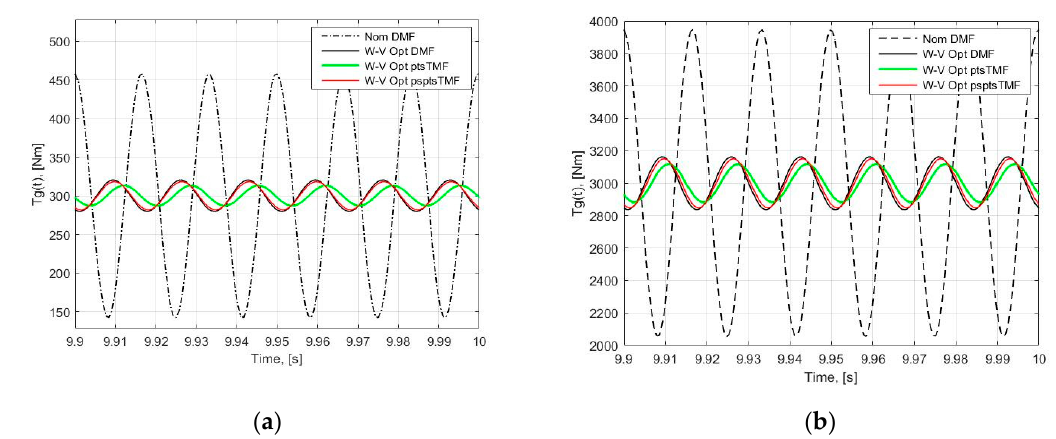
Figure 6. The torques at the transmission input shaft for operating engine speed n e = 1200 rpm for the DMF with nominal values of design parameters (12) and for vibration absorbers with obtained optimized design parameters: ( a ) for T m = 300 Nm, a e = 500 Nm; ( b ) for T m = 3000 Nm, a e = 3000